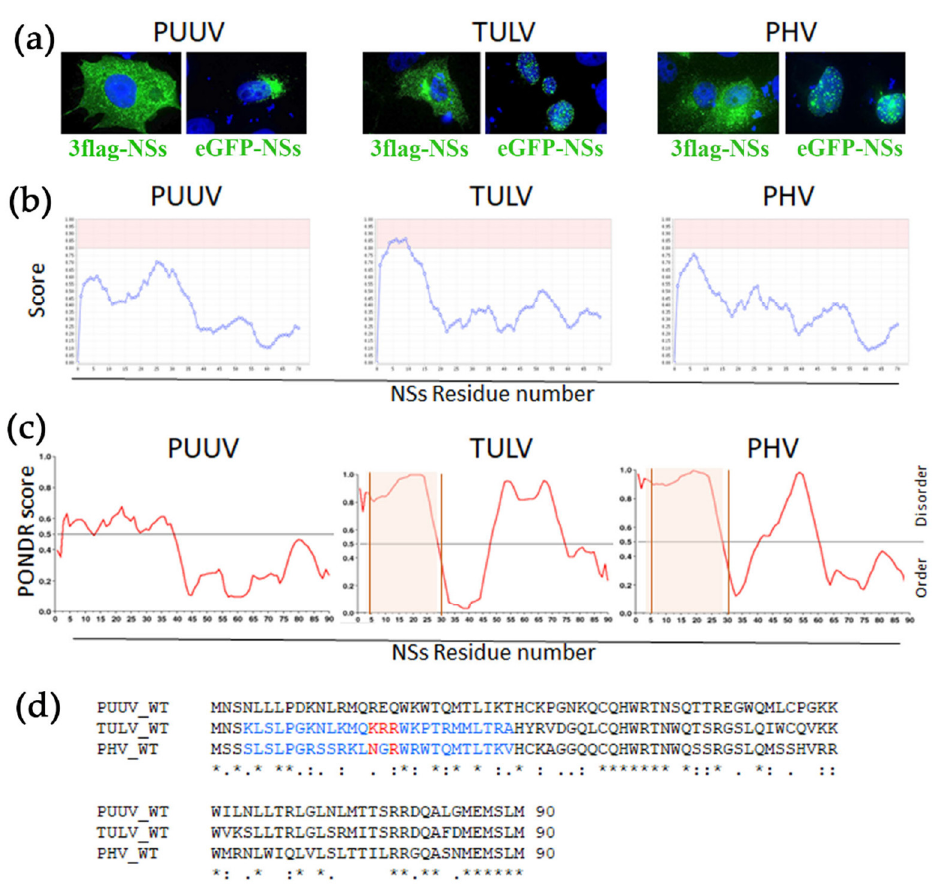
Figure 4. Identification of nucleolar like sequence (NoLS) in NSs proteins. ( a ) Subcellular localization of 3xFlag-NSs (left panels) and eGFP-NSs (right panels) of PUUV, TULV and PHV was obtained by immunofluorescence performed in VeroE6 cells at day 2 post transfection. 3xFlag-NSs was detected with anti-Flag mAb, then anti-mouse IgG Alexa-488 antibody, while eGFP-NSs was directly fluorescent. ( b ) shows predicted NoLS of NSs proteins of PUUV, TULV, and PHV determined by NoD software. Scores higher than 0.8 are highlighted in pink. ( c ) Prediction of naturally disordered NSs regions of the three orthohantaviruses was obtained by in silico analysis with the PONDR ® software and NoLS are highlighted in orange. ( d ) shows alignment of amino acid sequences of NSs from PUUV, TULV, and PHV, along with conserved amino acid residues (dots and stars below the set of sequences). The predicted NoLS sequence of TULV and the hypothetical one for PHV are highlighted in blue and the conserved polar residues in